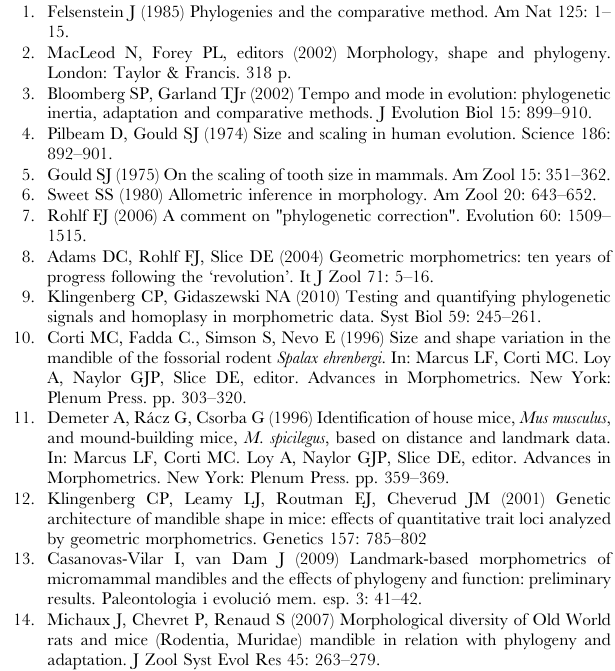
means for the Xerinae with a projection of the phylogenetic tree in the PC1-PC2 plot. The black mandible outlines represent shape changes with respect to consensus configuration (grey outline). Figure S3 Principal Component Analysis (PCA) of mandible shape, Callosciurinae phylogeny and dietary preferences. Size-corrected PCA of covariance matrix among species means for the Sciurinae with a projection of the phylogenetic tree in the PC1-PC2 plot. The black mandible outlines represent shape changes with respect to consensus configuration (grey outline). Figure S4 Figure 4. Canonical Variates Analysis (CVA) of squirrel mandible shape using dietary preferences as grouping variable. Plot of CV3 against CV4. Summary of classification results: see Table 3. Results for each particular case: see Table S3. Figure S5 Mean shapes of the main locomotor groups. Grey outline represents consensus shape. Table S1 List of squirrel species included in this study. For each species the number of specimens (n), geographical distribution, main habitat and diet, together with supplementary references for the data sources are given. Table S2 Probability of equality between all pairs of dietary groups in the Canonical Variates Analysis. Probability of equality ( p ) as well as Procrustes distances (Pdist) between all possible pairs of groups are given. Note that the tests find significant differences between all groups. For further details Table S3 Results of Canonical Variates Analysis of all